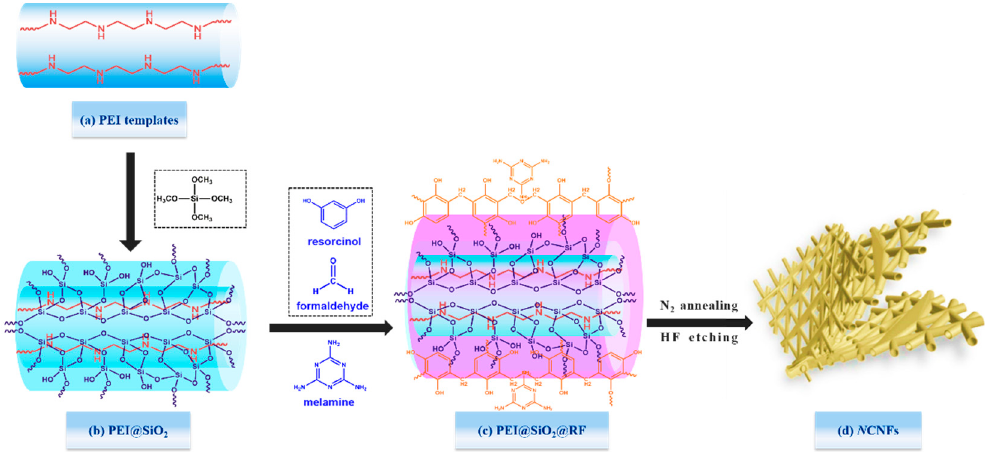
Figure 1. Schematic illustration for the synthesis of N-doped 3-dimensional carbon nanotube networks. ( a ) Linear polyethyleneimine (PEI) template, ( b ) deposition of SiO 2 layer on PEI surface to form the PEI@SiO 2 sample, ( c ) coating of RF onto the PEI@SiO 2 structure to form the PEI@SiO 2 @RF sample, and ( d ) the formation of N-doped carbon nanonet flakes ( N CNFs) and the demonstration of electron and ion transport pathway in carbon nanonet flakes (CNFs).